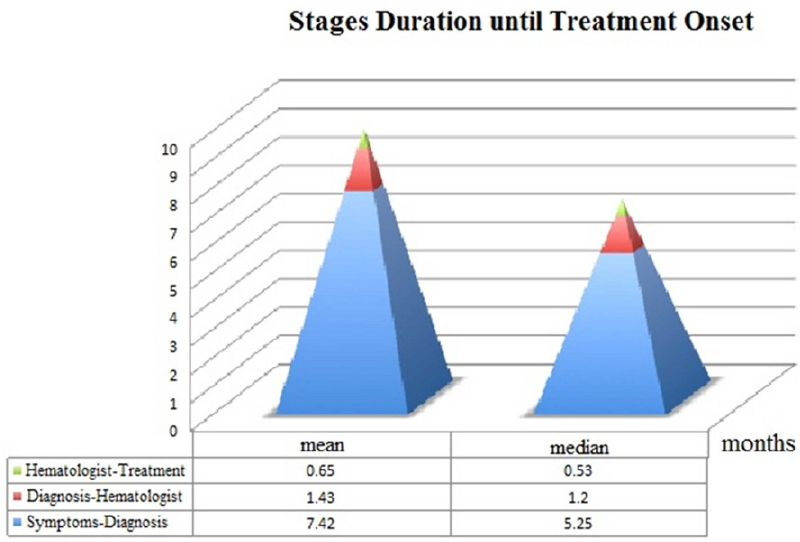
Figure 1 - Time between first signs or symptoms and commencement of DLBCL patients’ treatment. Blue: Time from signs or symptoms to diagnostic biopsy. Red: Time from diagnostic biopsy to first appointment with a hematologist. Green: Time from first appointment with a hematologist (including image staging, bone marrow biopsy and diagnostic review) to treatment commencement.